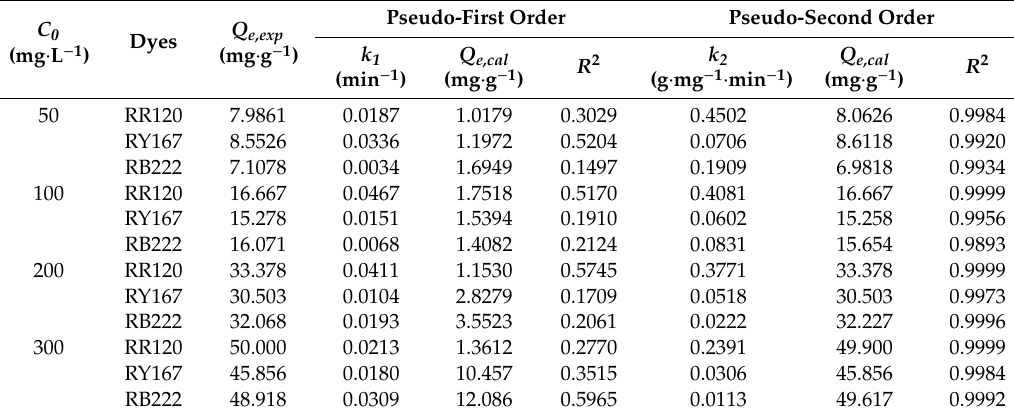
Table 2. Kinetic parameters of the pseudo-first order and pseudo-second order kinetic models for the adsorption of RR120, RY167, and RB222 onto the CL powders.